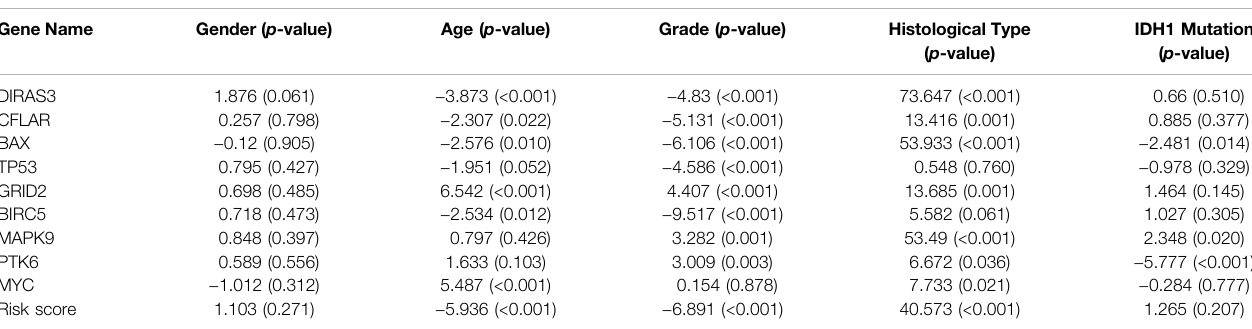
TABLE 3 | Clinical correlation